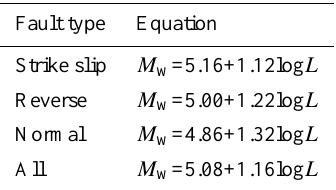
Table 3. Relationship between earthquake magnitude ( M w ) and rupture length ( L